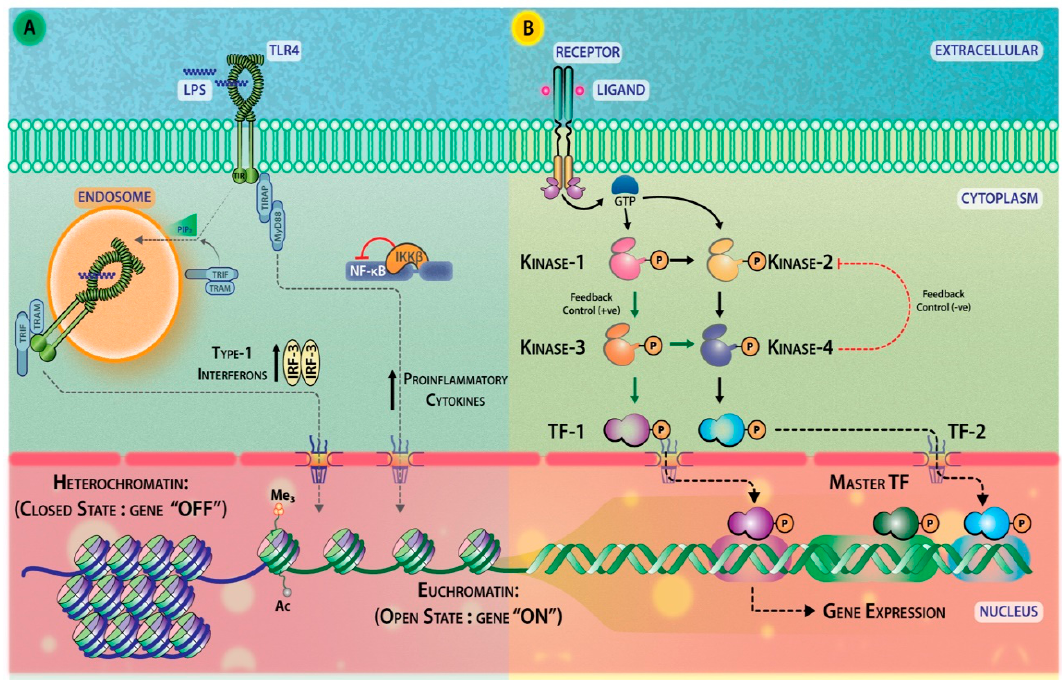
Figure 4. ( A ) Binding of the ligand to a receptor on the plasma membrane or its translocation to endosomes can trigger diverse signaling outputs. For example, binding of LPS to TLR4 receptor on the plasma membrane or on its translocation to the endosome can lead to the activation of distinct signaling intermediates and eventually specific transcription factors. ( B ) A variety of molecules (solid- adhesion molecules, extracellular matrix components; soluble factors) can elicit cell signaling. Receptor-ligand coupling triggers the enzymatic machinery that activates various transcription factors, which regulates gene expression.